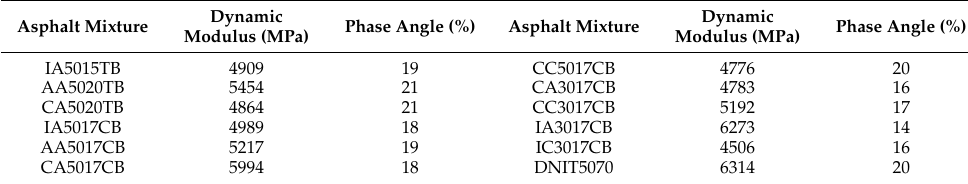
Table 9. Dynamic modulus of the asphalt rubber mixtures (20 ◦ C; 10